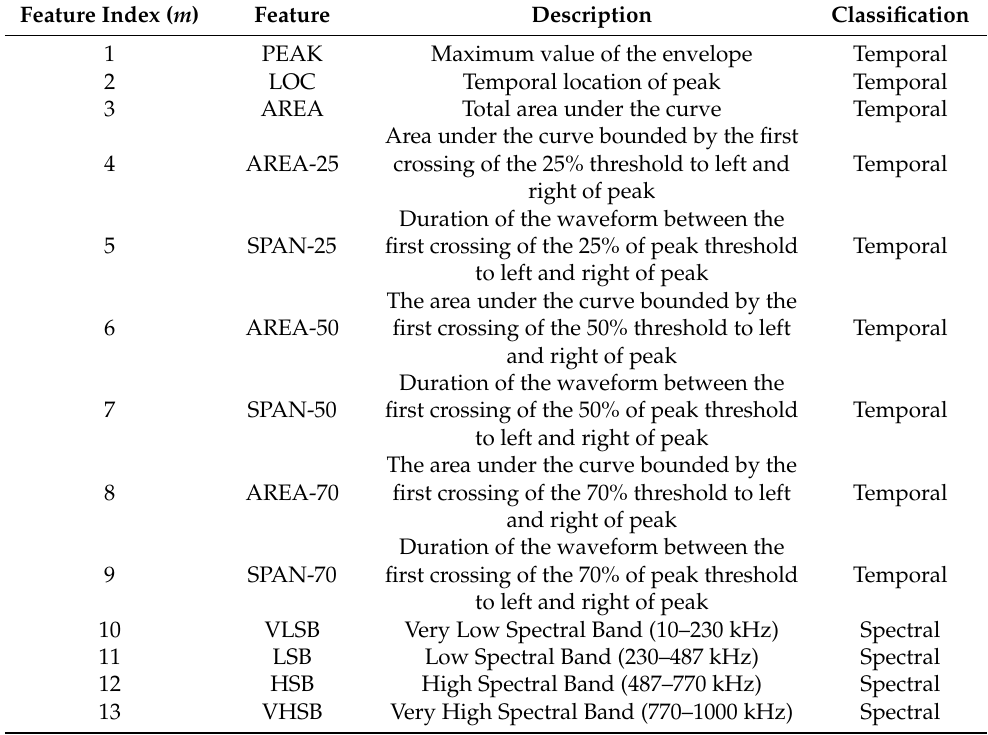
Table 2. List of temporal and spectral features extracted from ultrasonic envelopes. Feature Index ( m